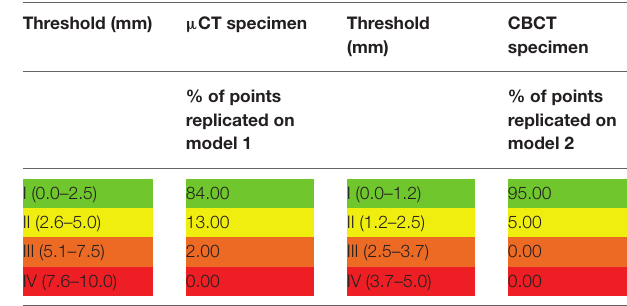
TABLE 2 | Results of the quantitative analysis of the imaging-based printing efficiency of the polyjet